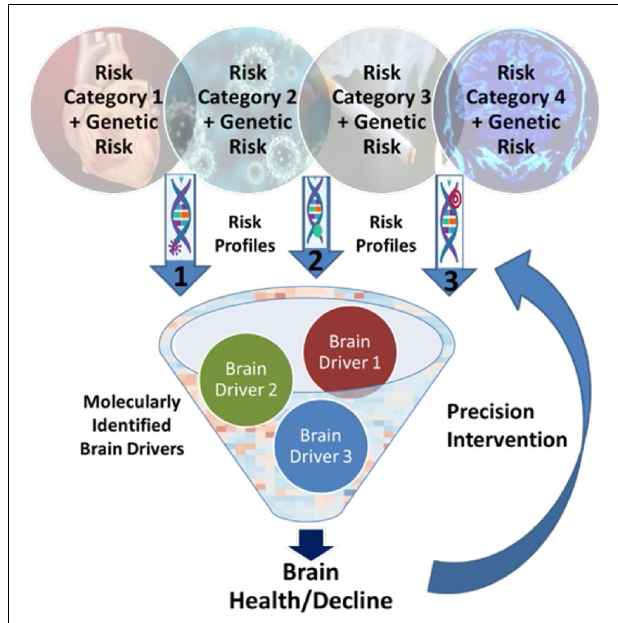
FIGURE 1 | The Precision Aging model. Specific risk factors are grouped into “Risk Categories” that can then be combined with known genetric variants to create individualized profiles of risk for age-related cognitive impairment (ARCI). Understanding the major “Brain Drivers” associated with each category that increase age-related changes in brain structure and function can lead to optimized preventive and therapeutic interventions.